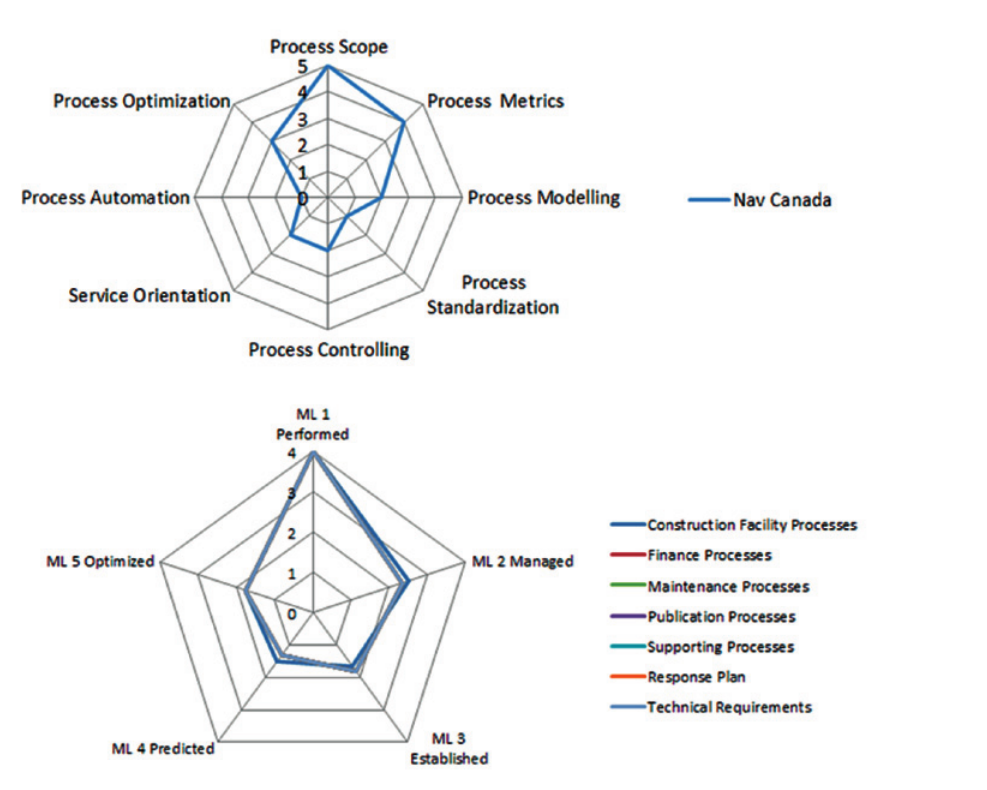
Fig. 3. NAV Canada ATC maintenance process maturity assessments. Since the process types marked by various colours mentioned on the right side of the ML diagram overlap, only the construction facility and technical requirement processes are